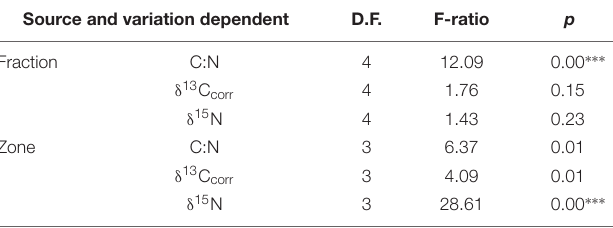
TABLE 4 | A Generalized Linear Model (GLM) to test the effect of size fractions and zone on C:N ratio and isotopes composition of C and N of mesozooplankton across a zonal gradient in the eastern south Pacific.